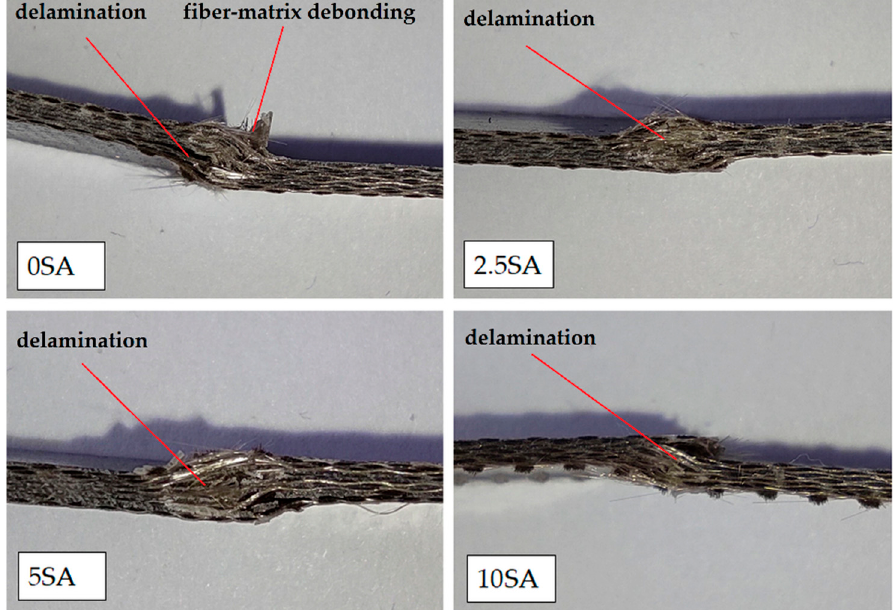
Figure 7. Images of the damaged area of composites modified with sunflower husk ash after the impact test .